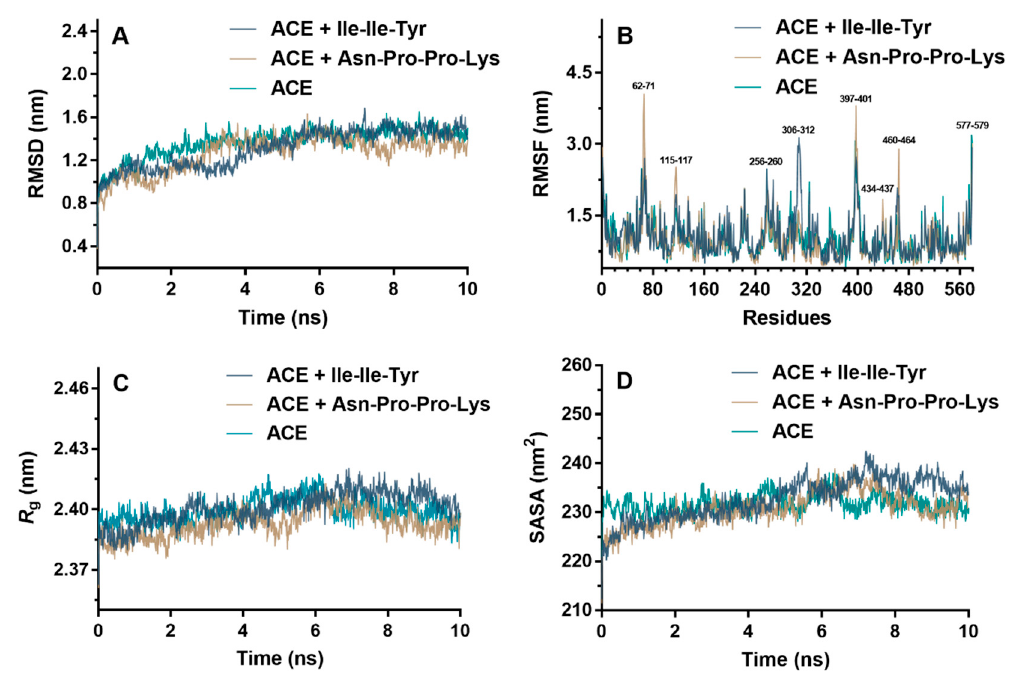
Figure 8. Molecular dynamics results of ACE with and without peptides Ile-Ile-Tyr and Asn-Pro-Pro-Lys: RMSD ( A ), RMSF ( B ), R g ( C ), SASA ( D ). RMSD was root mean square deviation. RMSF was root mean square fluctuation. R g was radius of gyration, SASA was solvent accessible surface area.